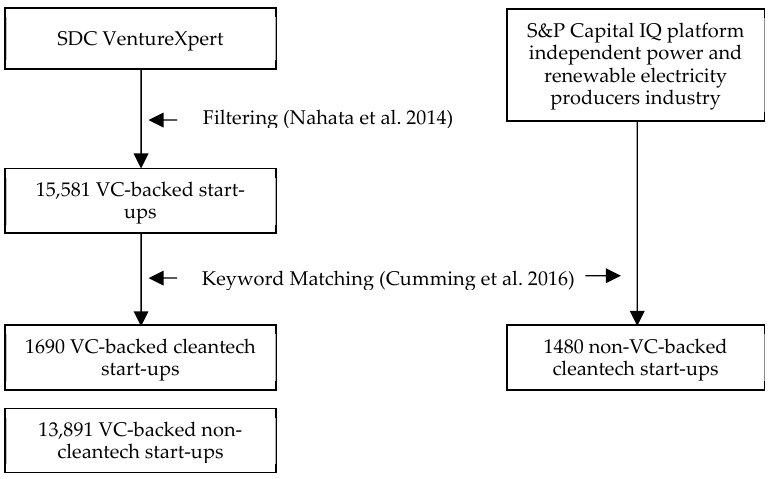
Figure 1. Sample construction process (Nahata et al. 2014; Cumming et al. 2016). As can be seen from Table 1A,B, the success rate of the VC-backed cleantech start- ups (18.55%) is more than two times greater than that of the non-VC-backed cleantech Renewable start-ups (8.31%), which is consistent with the VC value-adding effect (Sørensen 2007). However, the success rate of the VC-backed cleantech start-ups (18.55%) is slightly lower than that of the VC-backed non-cleantech start-ups (19.31%), which indicates the under- performance of VC cleantech investments. The global sample is relatively evenly distrib- uted across all countries, with investments in the United Kingdom accounting for approx- imately 20% of the entire sample. This assumes that the results are not affected by a single country. Table 1. Sample distribution (SDC VentureXpert; S&P Capital IQ). (A) Developed Economies.